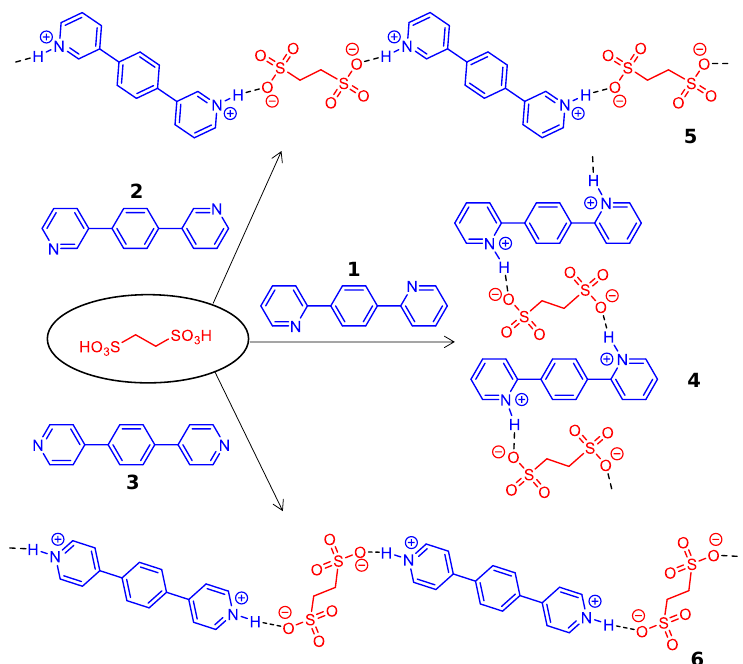
Figure 1. Schematic diagram of the reaction of 1,2-ethylenedisulfonic acid with 1 – 3 to give polymeric structures 4 – 6 , respectively.